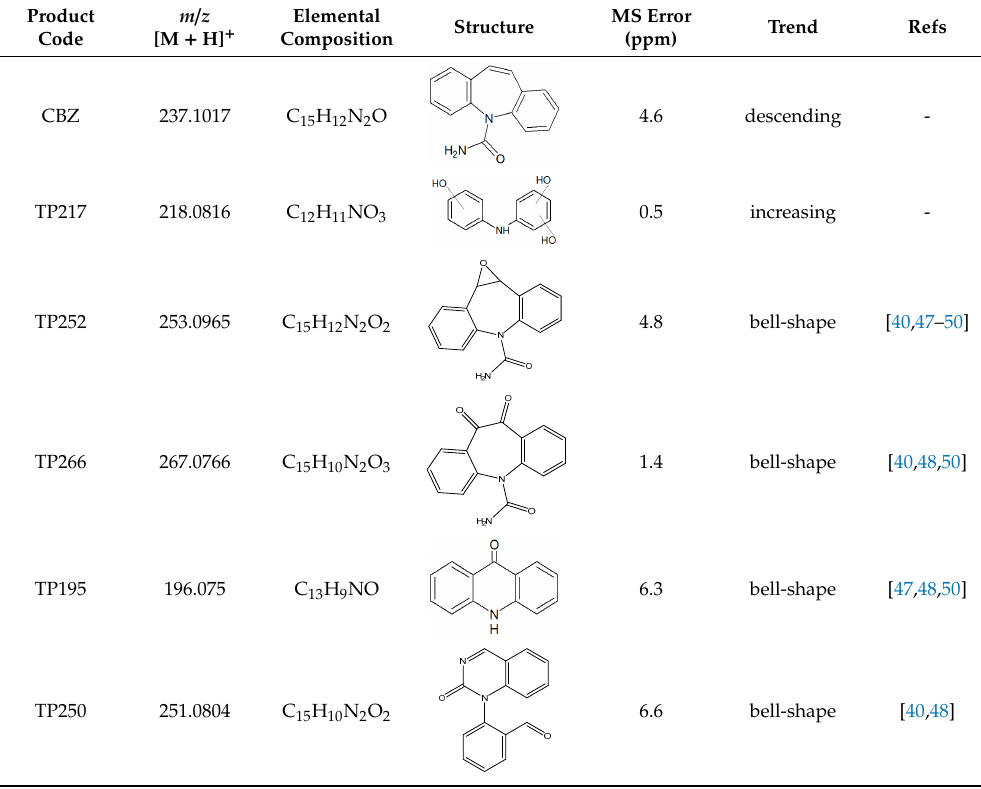
Table 4. Transformation products of carbamazepine by photocatalysis employing conventional commercial TiO 2 powder (Degussa P25-TiO 2 nanoparticle).